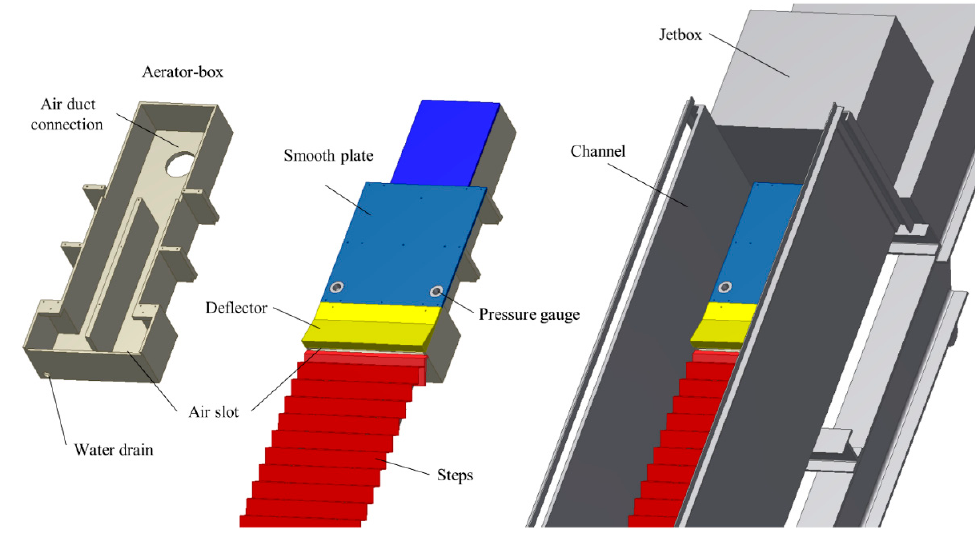
Figure 2. Components and placement of the aerator at the head of the stepped channel.